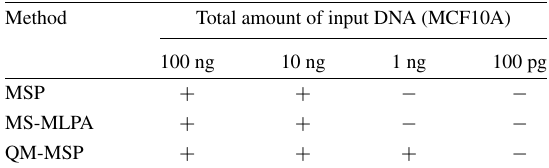
Results of a dilution to assess the minimum required input DNA for different non-quantitative (MSP) and quantitative (QM-MSP and MLPA) methylation assays ( + indicates positive signal for RARB)